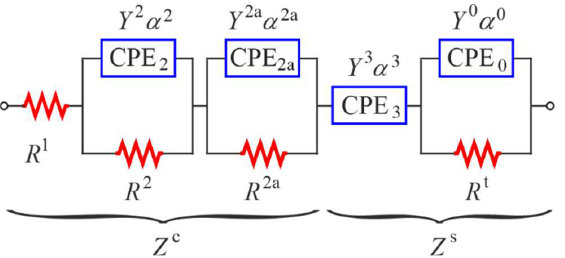
Figure 7. Electrical equivalent circuit used in the analysis of impedance spectra, in which: R 1 —resistor representing resistance of liquid phase of concrete, R 2 , R 2 a —resistors describing resistance of a double layer at the interface of concrete–pore solution, CPE 2 and CPE 2 a —constant phase elements described by the parameters Y 2 , Y 2 a , α 2 , α 2 a which represents pseudo capacitance of the double layer, CPE 3 —constant phase element with parameters Y 3 , α 3 which represents the transition zone between concrete and steel, R t —the charge transfer resistance through the pore solution–metal interface, CPE 0 —constant phase element with parameters Y 0 , α 0 which represent pseudo capacitance of the double layer at the interface of pore solution–metal; Z c and Z s —groups of parameters describing concrete and steel,